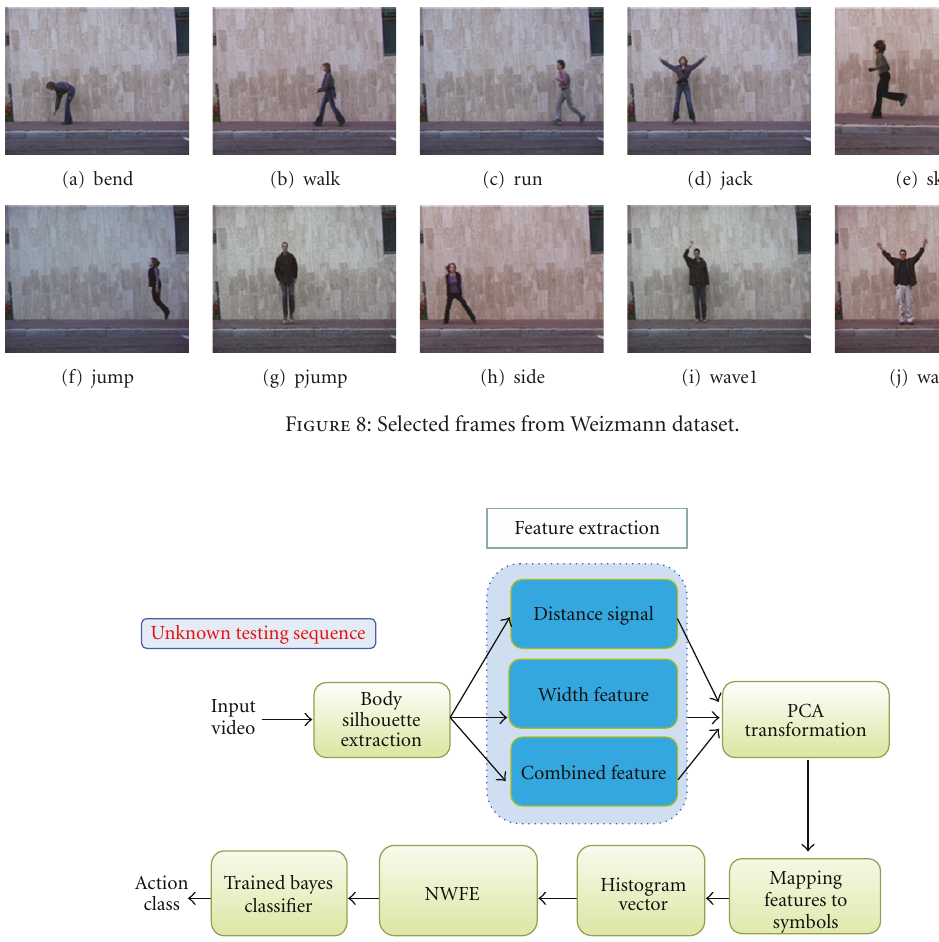
Figure 9: The flowchart for the comparison of three feature extraction